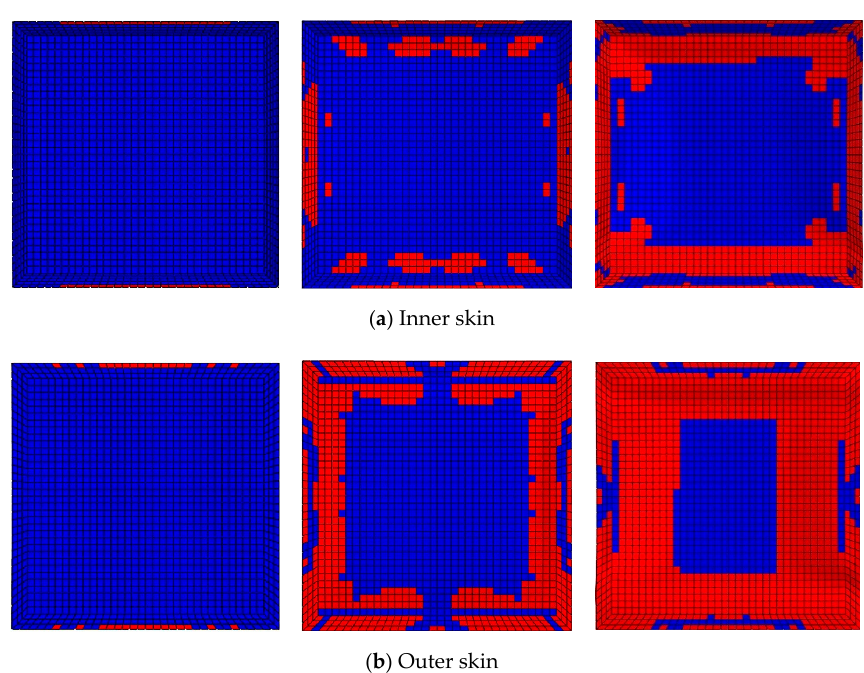
Figure 16. Honeycomb damage propagation in the CD0 Model. ( a ) the damage propagation of inner skin; ( b ) the damage propagation of outer skin.